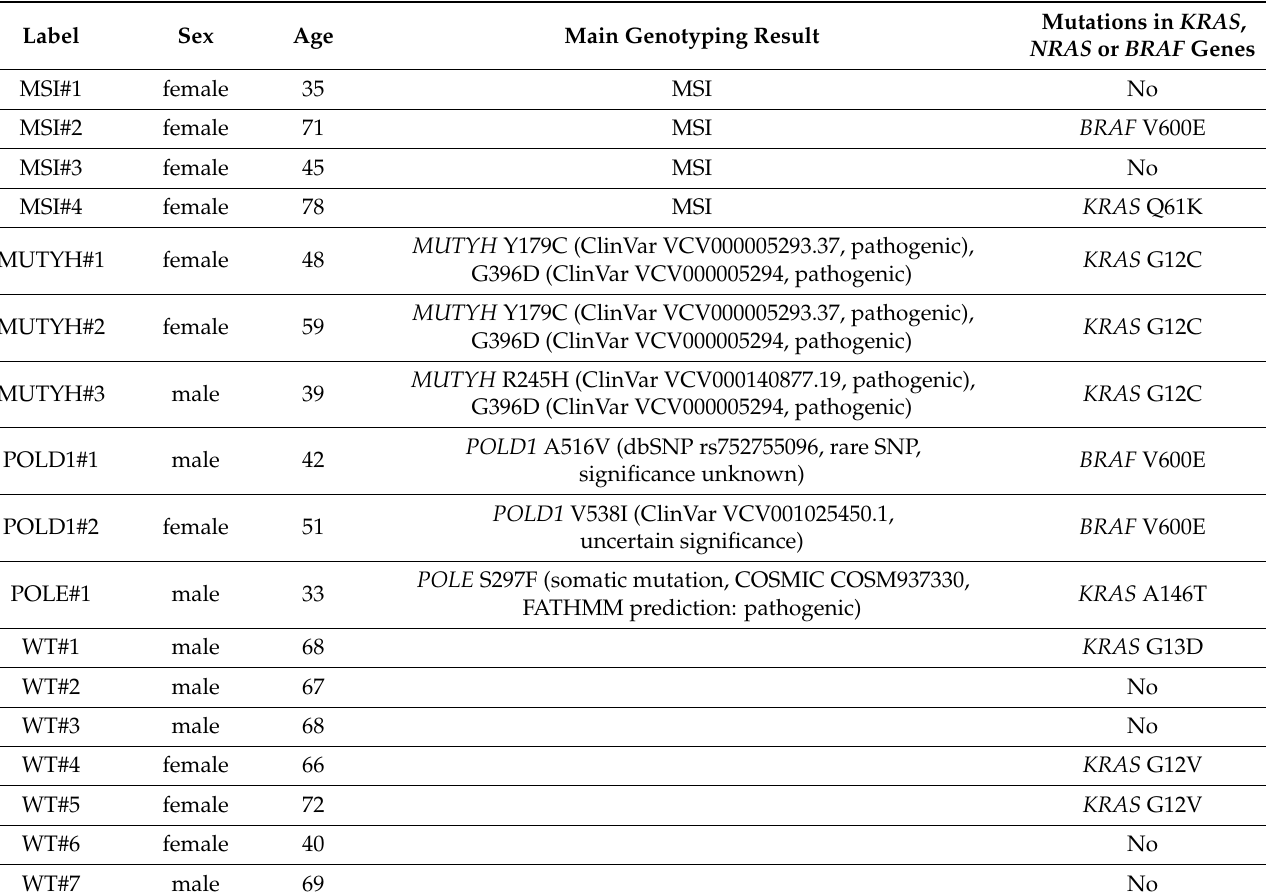
Table 1. Characteristics of colorectal carcinoma cases studied with the BotSeqS